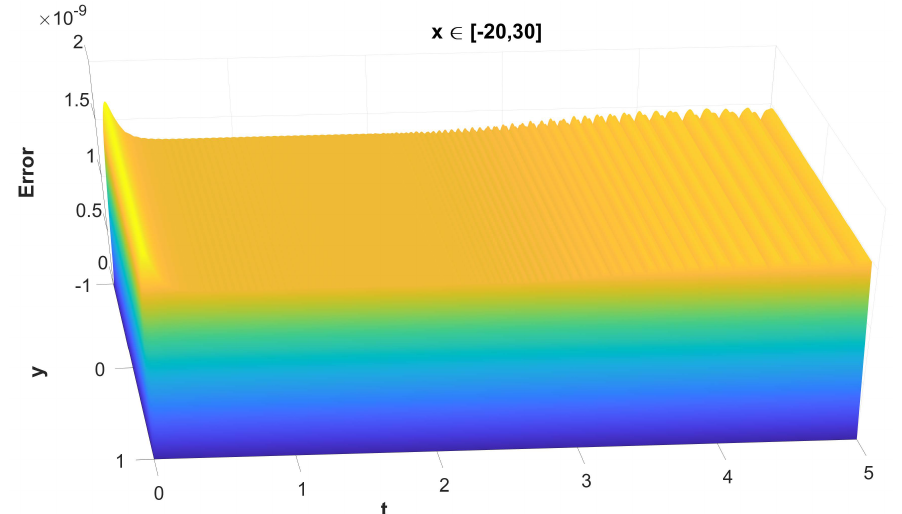
Figure 13. The maximum, along x , absolute error of the solution versus t and y with the use of finite difference schemes for the spatial semi-discretisation.